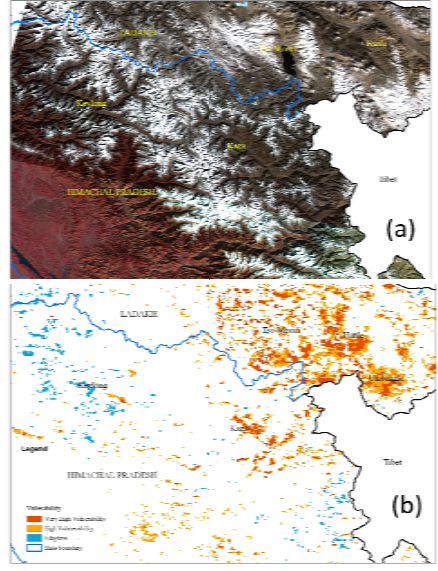
Fig.4. False color composite AWIFS data showing Temper modelled potentially vulnerab relations derived from the study patches in Central east where as zones (sky blue patches)